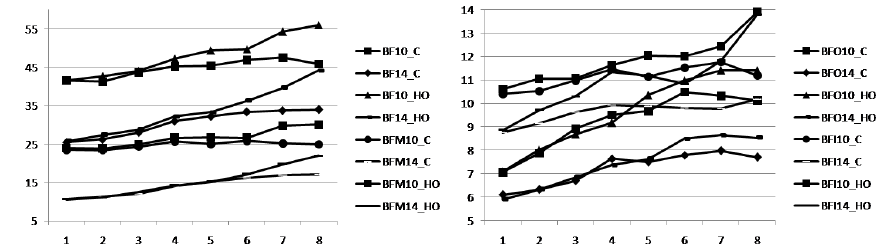
Figure 3. Changes in ultrasonic back fat depth and its layers as functions of feed in pigs of the Iberian breed.